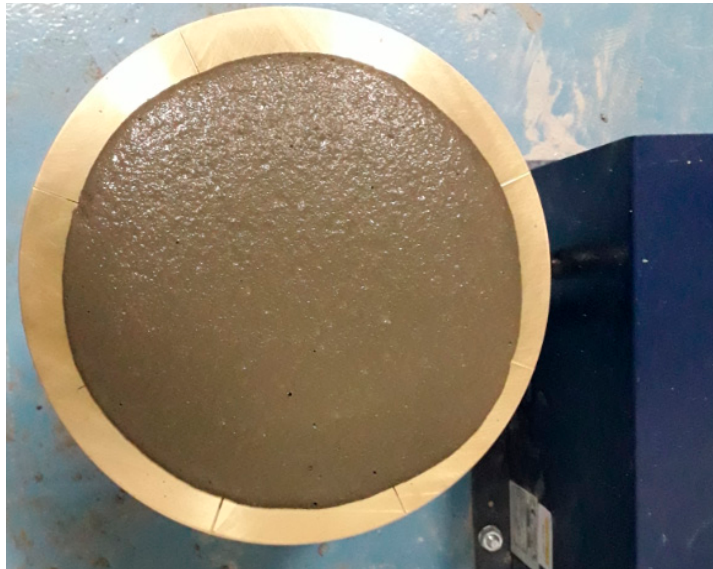
Figure 2. Flow table to measure the flow properties of mixes. Table 2. Flow properties of mortar mixes.